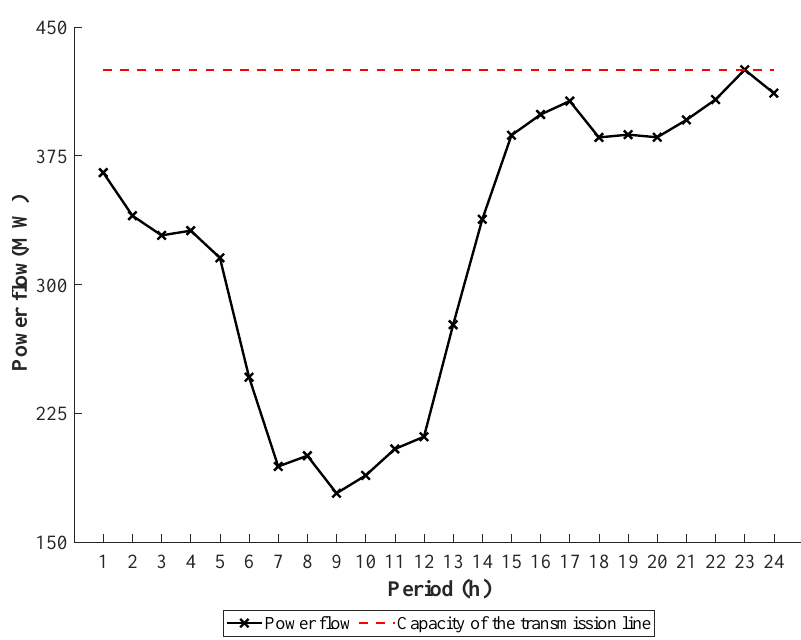
Figure 16. Power flow at transmission line 33 in Case